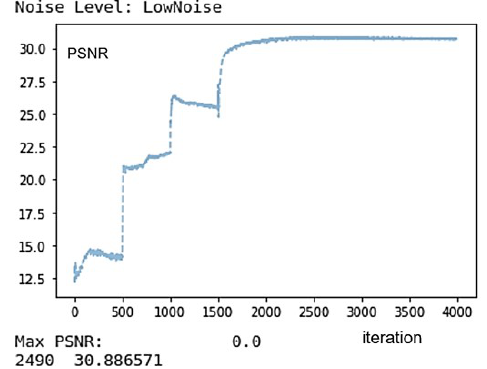
Figure 4. Showing the CPSNR values in the process of reconstructing the Kodak No. 17 image as the iteration progresses.